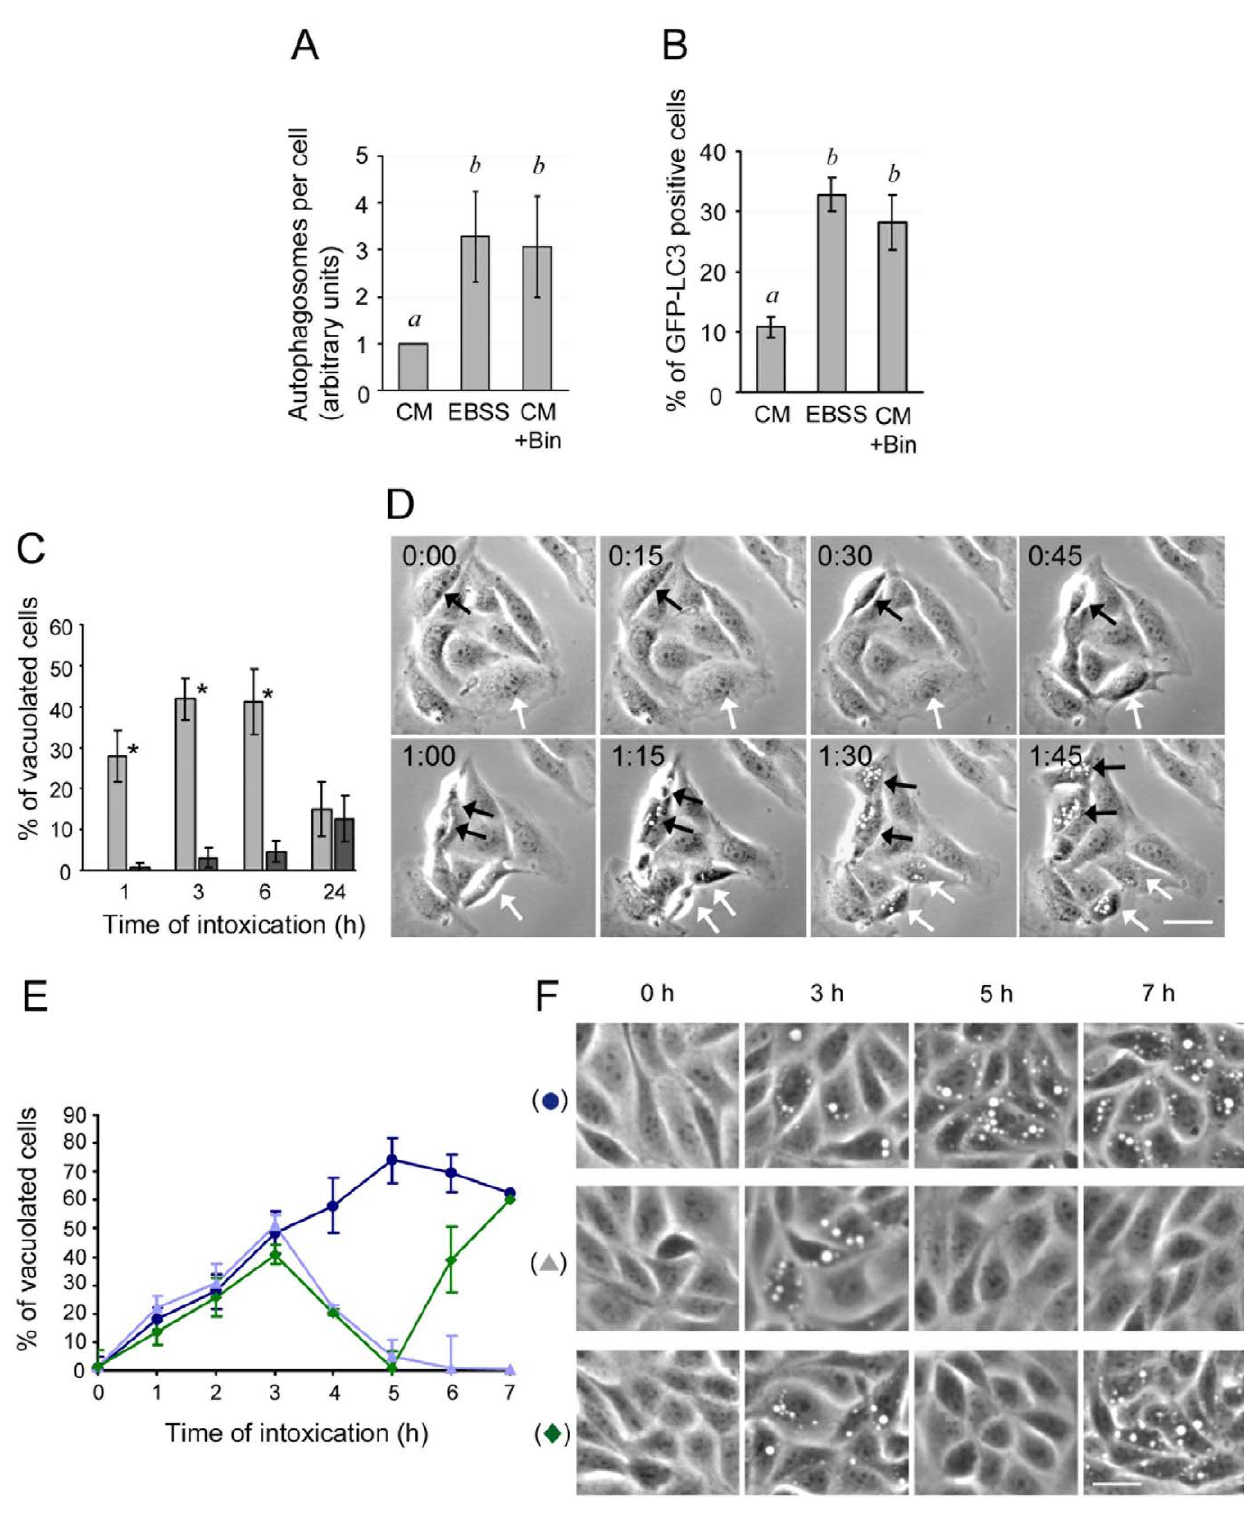
Figure 4. Autophagy is enhanced in Bin treated cells and contributes to vacuolation reversion. (A) MDCK-Cpm1 cells were grown for 6 h in complete medium in the absence (CM) or the presence of Bin (CM + Bin), or in nutrient-free medium in the absence of the toxin (EBSS), and then processed for EM analysis. Pictures from randomly chosen EM sections were analyzed for the presence of autophagosomes as defined in figure 2. The results are expressed as the number of autophagosomes per cell. Mean values 6 SD, n = 3. Different letters indicate statistically significant differences; P , 0.05. (B) MDCK-Cpm1 cells expressing GFP-LC3 were grown under the conditions described above. At the indicated time, the number of GFP-LC3 positive cells was scored. Mean values 6 SD, n = 3. Different letters indicate statistically significant differences; P , 0.05. (C) Cells were grown in complete medium or in nutrient-free medium in the presence of toxin. At the indicated period of time, the percentage of vacuolating cells